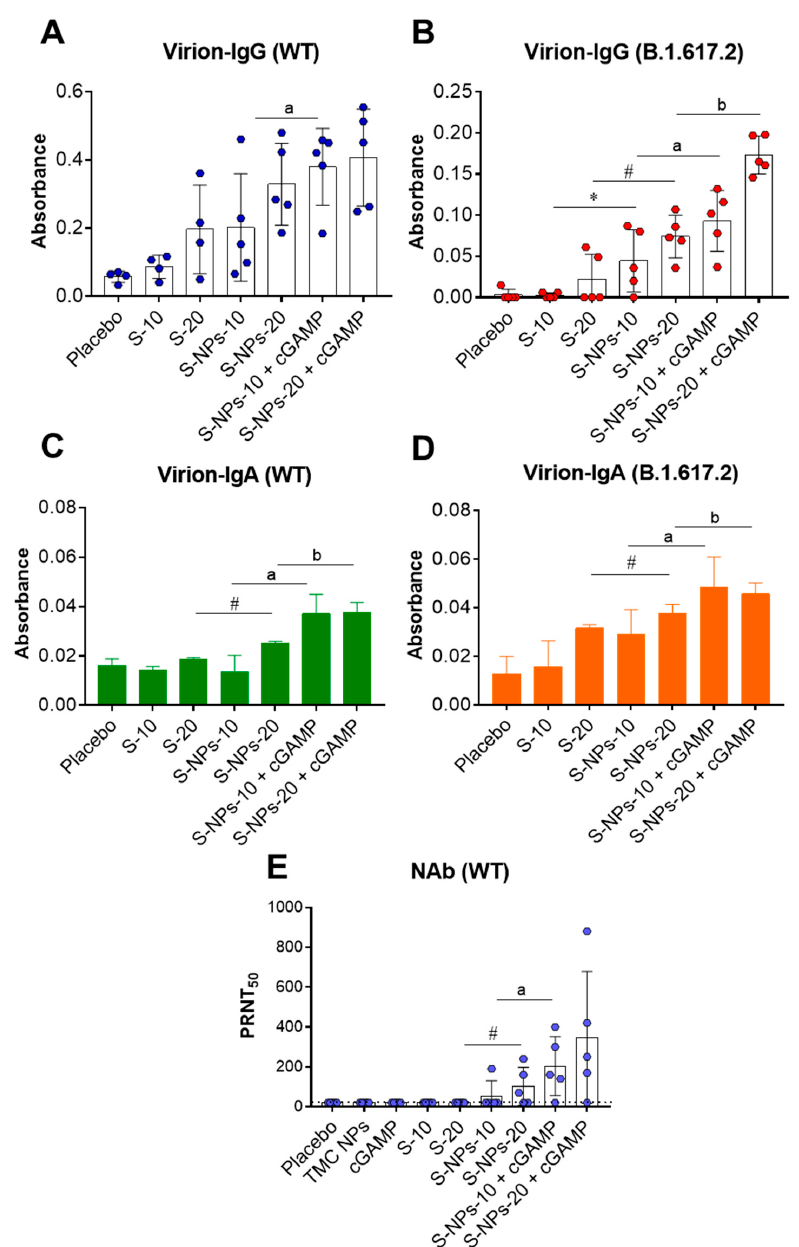
Figure 5. Anti-viral activity of anti-SARS-CoV2 spike antibodies. Sera of immunized mice 2 weeks after last booster at a final dilution of 1:50 were tested for virion-IgG ELISA assay against WT ( A ) and Delta virus variant ( B ). Pooled sera at 1:10 dilution were performed by virion-IgA ELISA assay against WT ( C ) and Delta variant ( D ) with three independent experiments. Neutralizing antibody titers were determined by PRNT 50 with live WT virus ( E ). Data are presented as mean ± SD. * and # indicate significant differences between soluble S-protein and S-NPs at 10 and 20 µ g/dose, respectively. “a” and “b” indicate significant differences of S-NPs compared with S-NPs + cGAMP at 10 and 20 µ g/dose, respectively ( p < 0.05). Dotted line indicates LoD of the